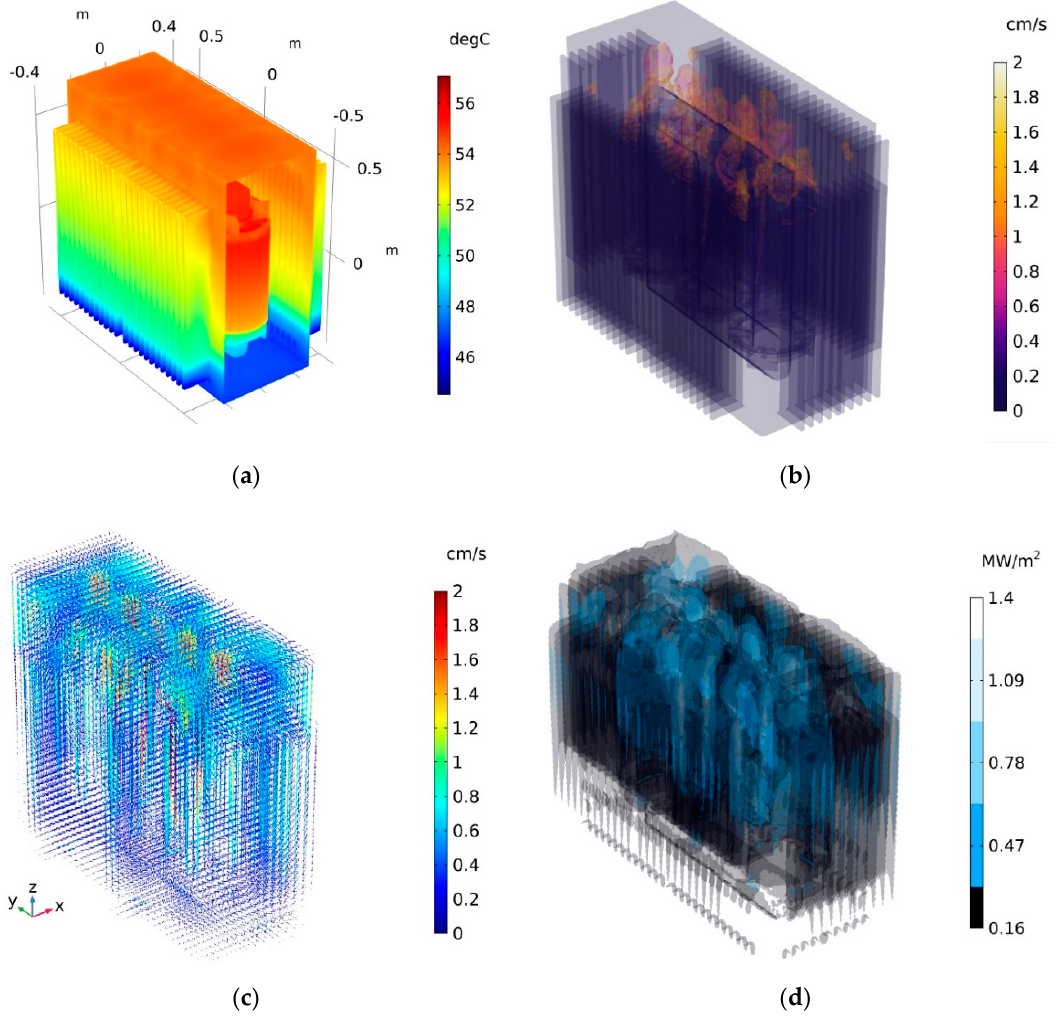
Figure 14. Transient simulation results of ( a ) temperature field ( b ) fluid field ( c ) vector diagram of oil stream and ( d ) thermal flux distribution.